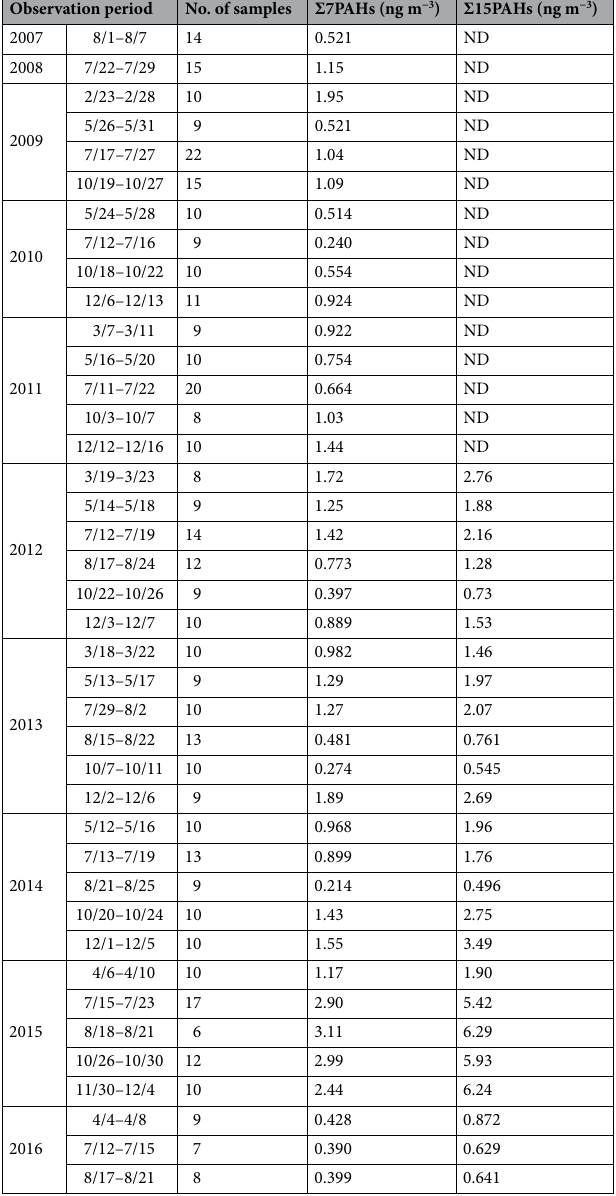
Table 1. Sampling periods, numbers of samples, and Σ7PAH and Σ15PAH concentrations, 2007–2016. ND no